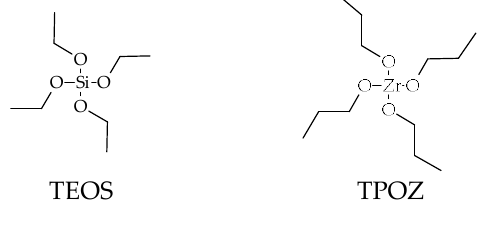
Figure 1. Precursors’